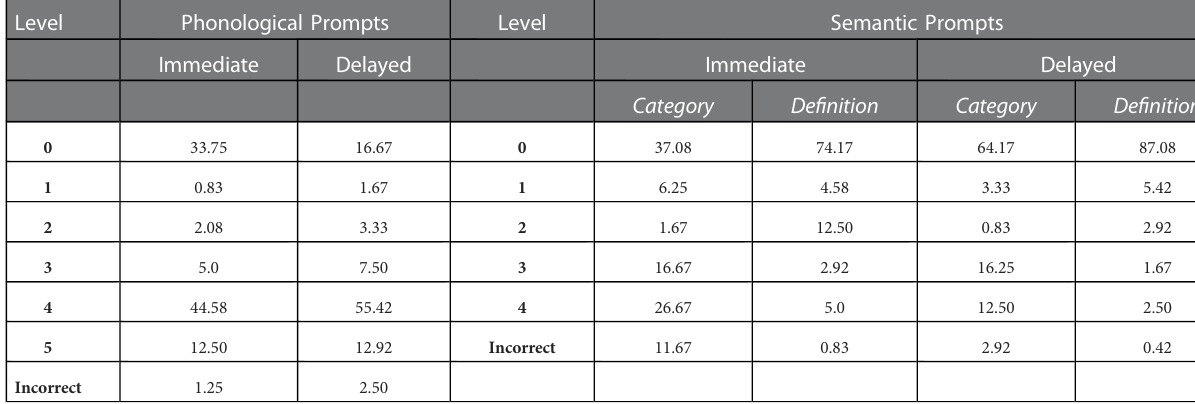
TABLE 11 Percentage of successful responses for each level of